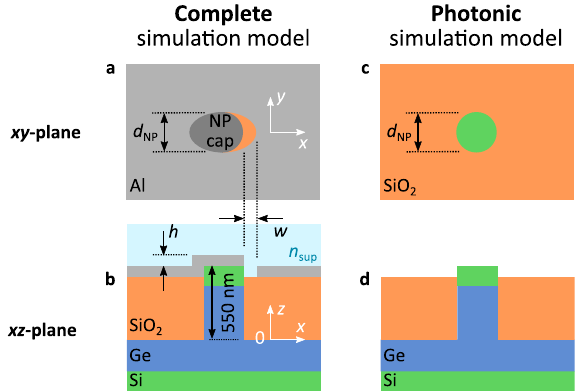
Figure 1. Sketch of the ( a ), ( b ) complete simulation setup used to model the NP-PD and ( c ), ( d ) simplified photonic simulation model without metallization layer, Layer structures as well as structural parameters used throughout this work are indicated in the top view ( a ), ( c ) and cross-sectional images ( b ), ( d